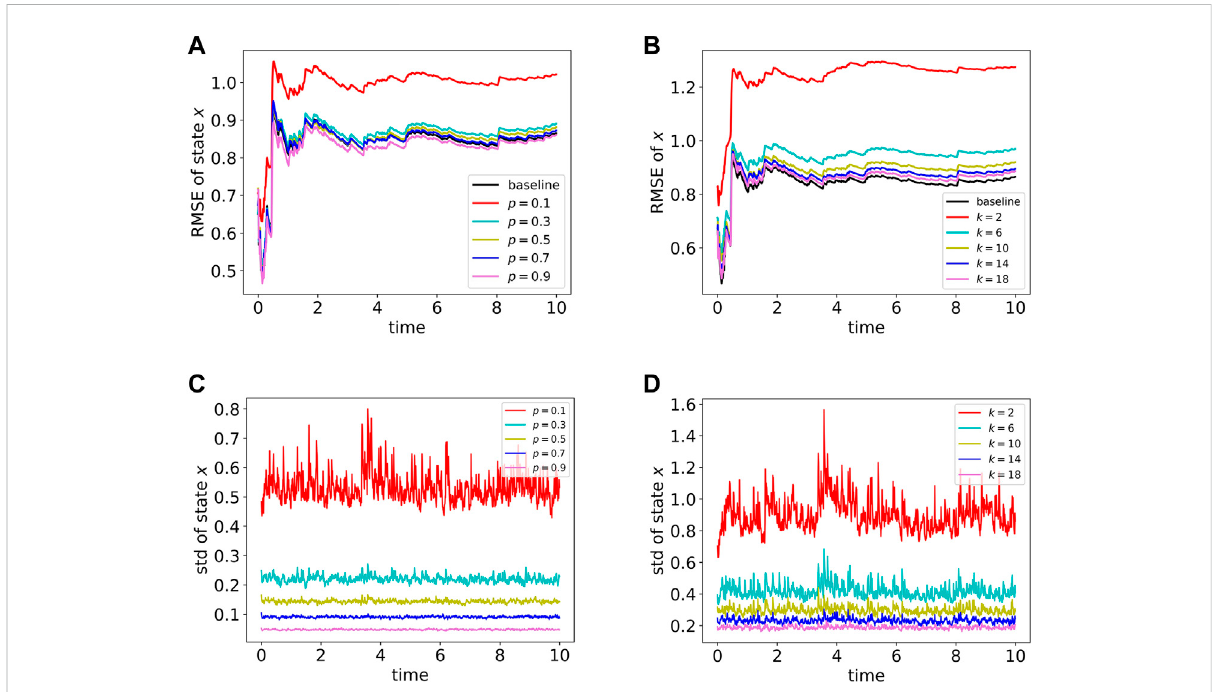
FIGURE 1 MeanRMSEandstandarddeviationof x ++ i , k , i (cid:2) 1 , 2 , ... , N fortwonetworktopologytypes.TheRMSEfortheEnKFisthebaseline. (A,B) showthe Mean RMSE of all particles for the Particle Network EnKF and the RMSE for EnKF as the baseline for the ER and WS graphs, respectively. (C,D) display the Standard deviation of x ++ i , k ( i = 1, 2, ... , N ) at each step k to demonstrate the effects of the network topology on